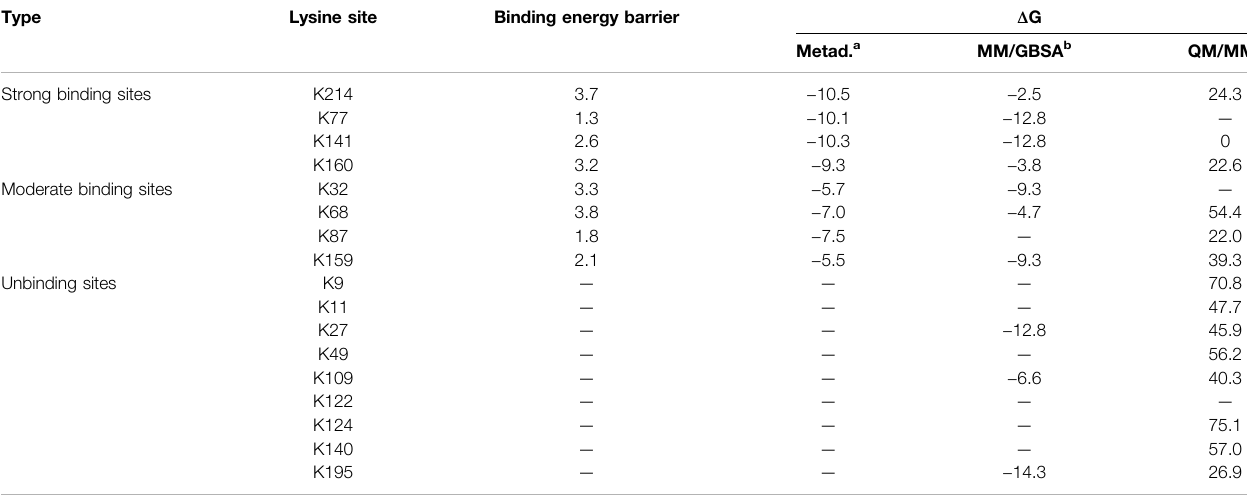
TABLE 1 | Comparison between the binding free energies calculated by metadynamics and molecular mechanics/generalized Born surface area (MM/GBSA) method. Values are given as the absolute values for all binding free energies. Units are in kcal · mol − 1 .